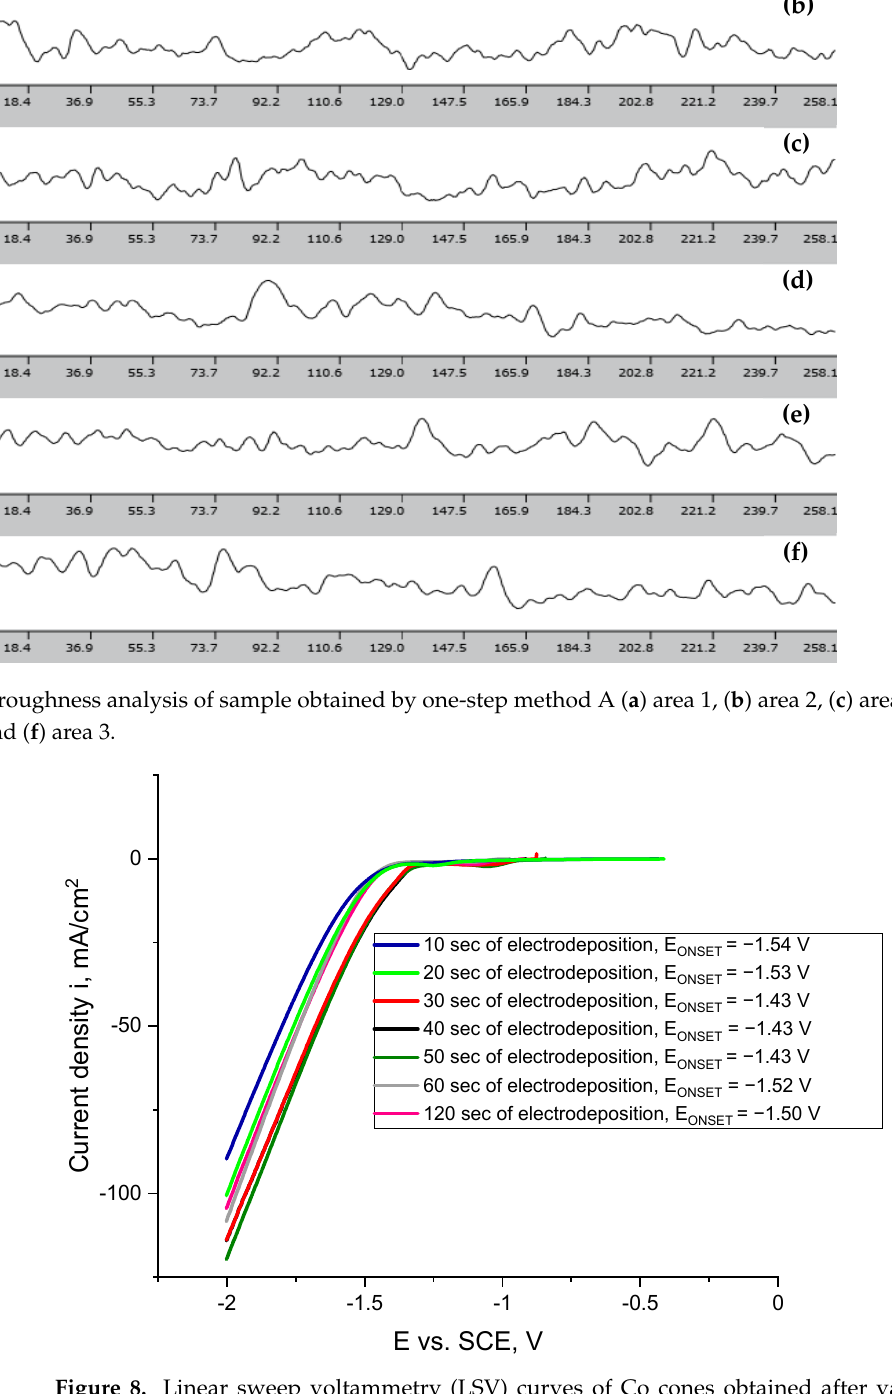
Figure 8. Linear sweep voltammetry (LSV) curves of Co cones obtained after various time of electrodeposition using one-step method B in 1 M NaOH solution.